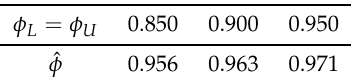
Table 7. Ten thousand Type VI cointegration residuals with path length 510 and given mean-reversion coefficient φ are generated and contaminated with six non-reversible jumps ( λ p = 6) with median size m p = 0.10. Depicted are the average estimated mean-reversion coefficients ˆ φ compared to their true values φ